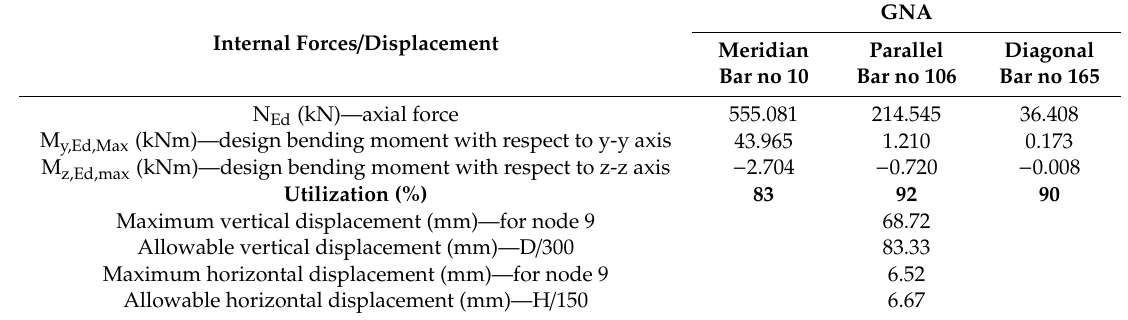
Table 12. Values of the internal forces and the maximum horizontal and vertical displacement of node 9 for